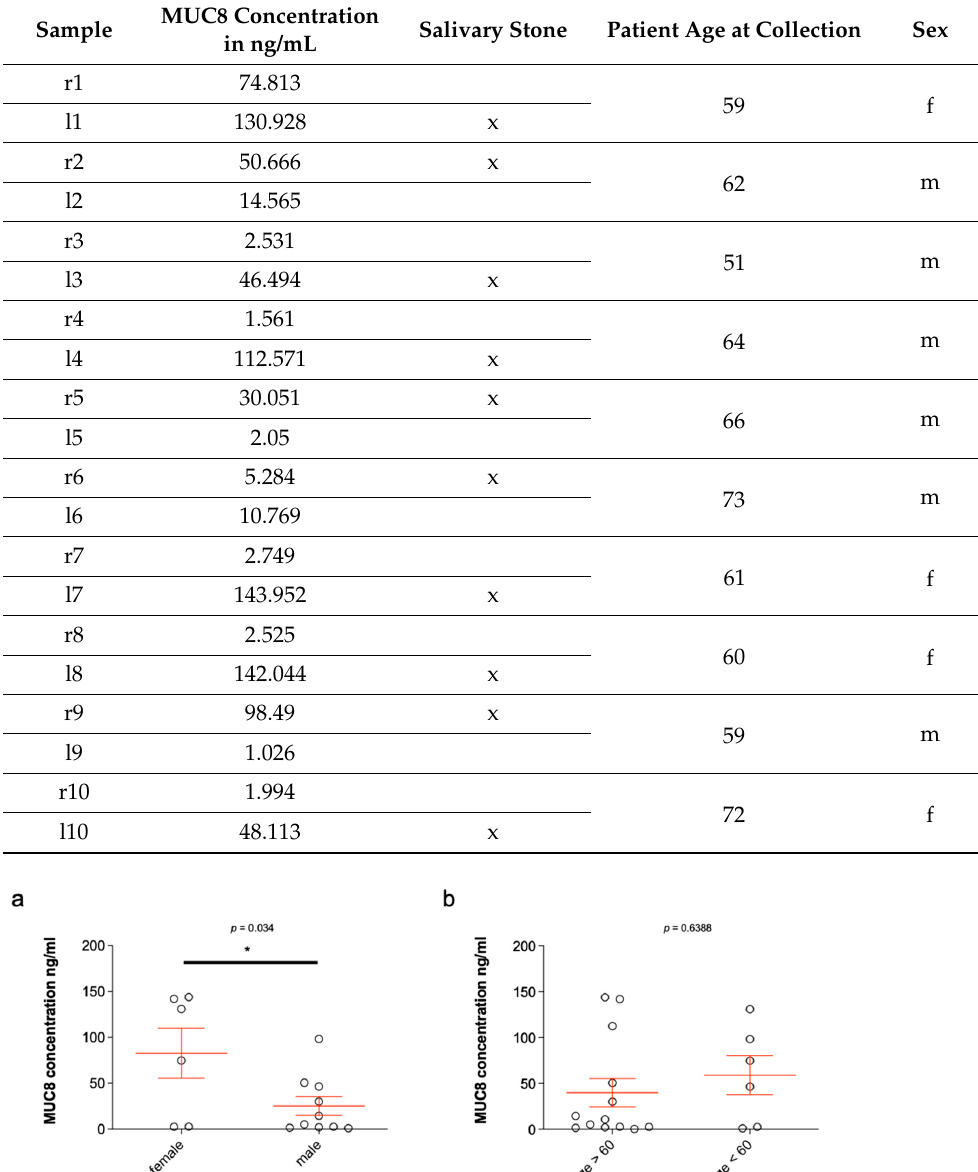
Figure 5. MUC8 concentrations in 20 saliva samples from the excretory ducts of the submandibular glands of 10 patients who had a salivary stone in the excretory duct system of the submandibular gland on one side (x) and not on the other (Table 2) and statistical analysis in relation to sex ( a ) and age ( b ). The concentrations of MUC8 are shown in ng/ml in each case. The MUC8 concentrations shown in the bar chart (Table 2) illustrate the large scatter of concentration values between the individual saliva samples. Statistical analysis of the determined MUC8 concentrations shows statistically significant values in the distribution by gender ( a , p ≤ 0.034) and no significant values for distribution by age ( b , Table 2) (* p ≤ 0.05).